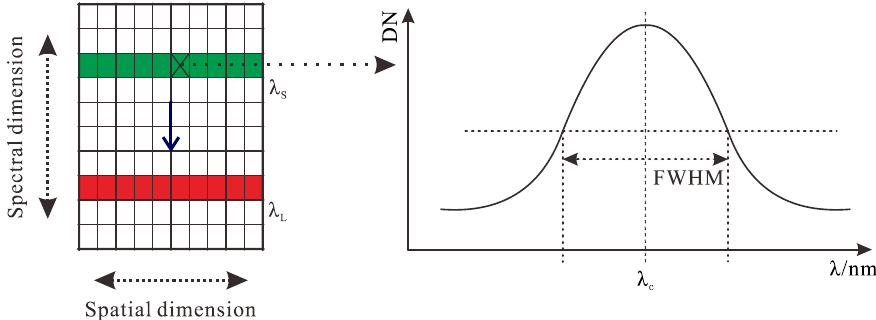
Figure 19. Continuous spectral calibration method.